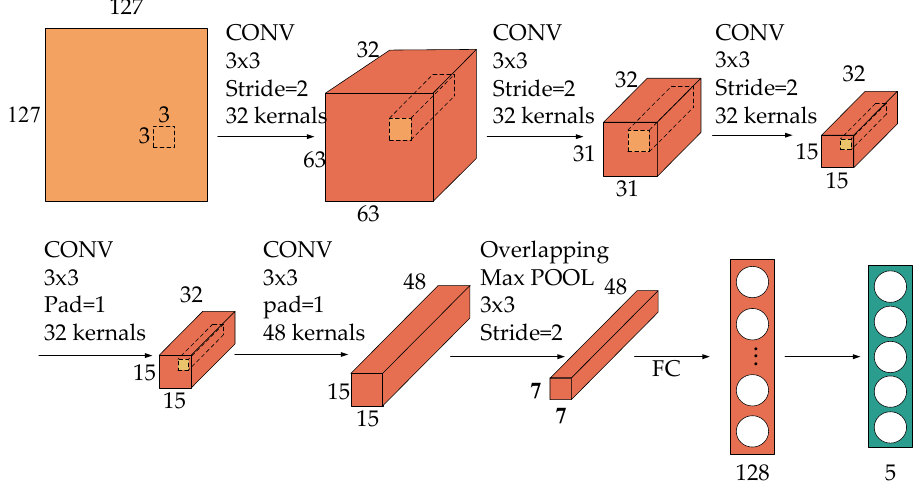
Figure 3. Improved model structure diagram.